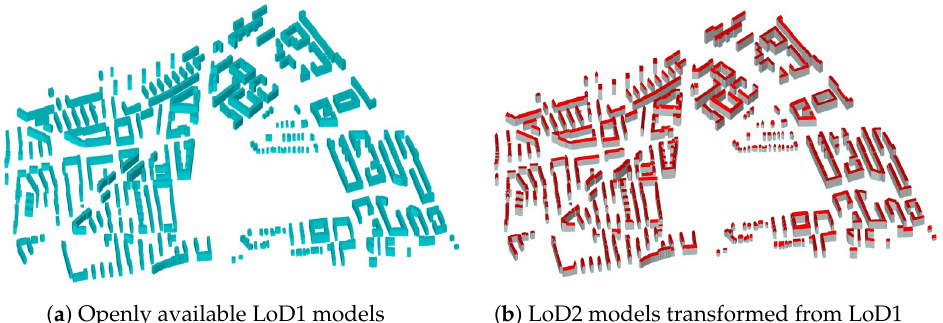
Figure 13. ( a ) Representation of open LoD1 CityGML building models (OD1); ( b ) representations of the transformed LoD2 CityGML building models (TD2).